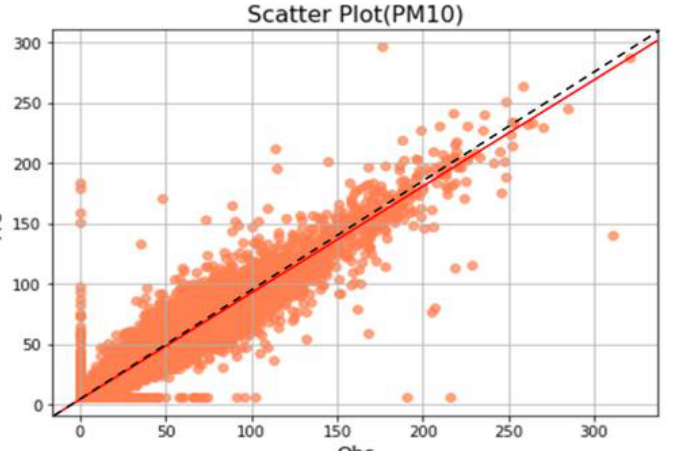
Figure 7. Comparison results of predicted fine dust with observations. The regression line of observed and predicted data is indicated in red.